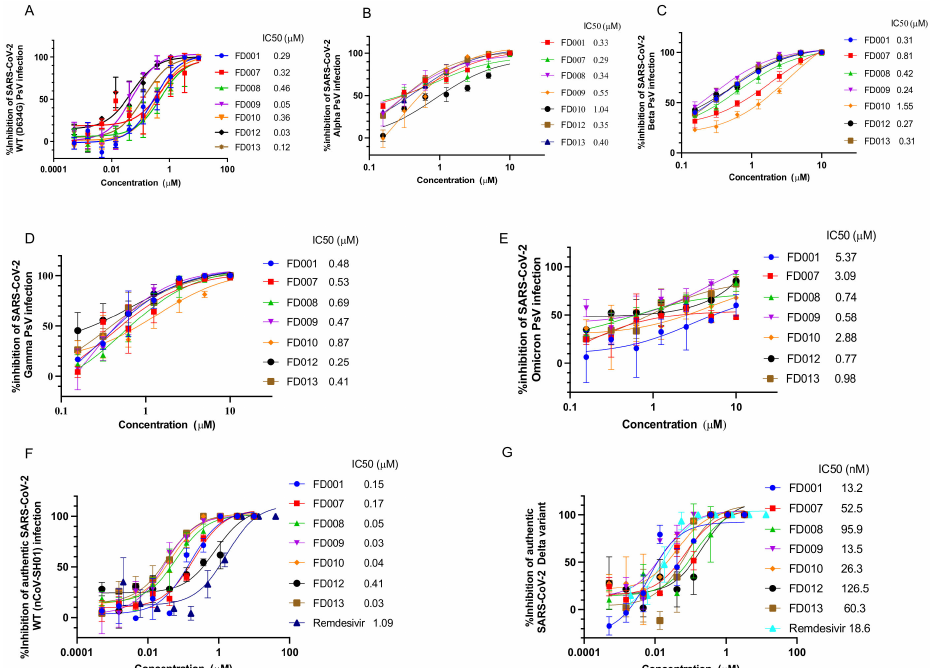
Figure 1. FD-compounds effectively inhibited infection of SARS-CoV-2 and its variants. ( A ) FD- compounds inhibited SARS-CoV-2 PsV infection in hACE2-293T cells; ( B – E ) FD-compounds inhibited infection of pseudotyped SARS-CoV-2 Alpha (B.1.1.7), Beta (B.1.351), Gamma (P.1), and Omicron (B.1.1.529) in Caco2 cells; ( F , G ) the plaque reduction assay was used to detect the inhibitory ac- tivity of FD-compounds against infection of authentic SARS-CoV-2 WT (MOI = 0.01) and Delta (B.1.617.2) variant in Vero E6 cells (MOI = 0.0025). Data are means ± SD of triplicate samples from a representative